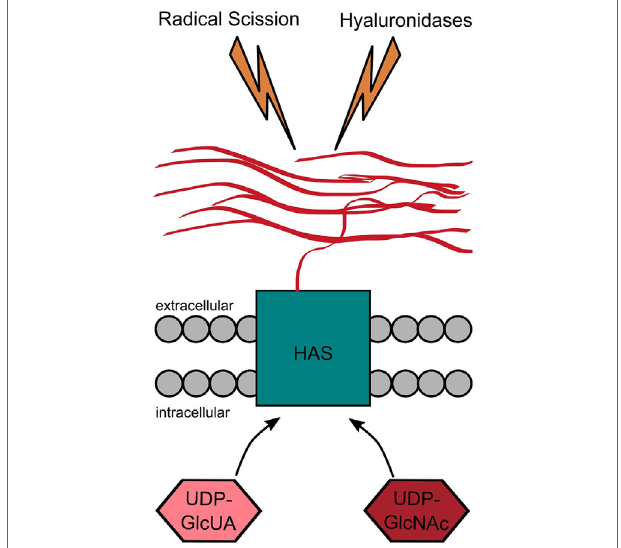
FiGURe 4 | Hyaluronan (HA) metabolism. HA is produced by the HA synthases that catalyze the alternating addition of the uridine diphosphate (UDP)-activated monosaccharides (UDP-GlcUA and UDP-GlcNAc) to the reducing end of the growing HA chain. While the monosaccharides are added at the cytoplasmic site, the HA chain is simultaneously extruded to the extracellular space. HA is degraded either by radical scission or by enzymatic degradation. The latter one can either happen within the tissue itself or after drainage to the lymphatic system at different places within the